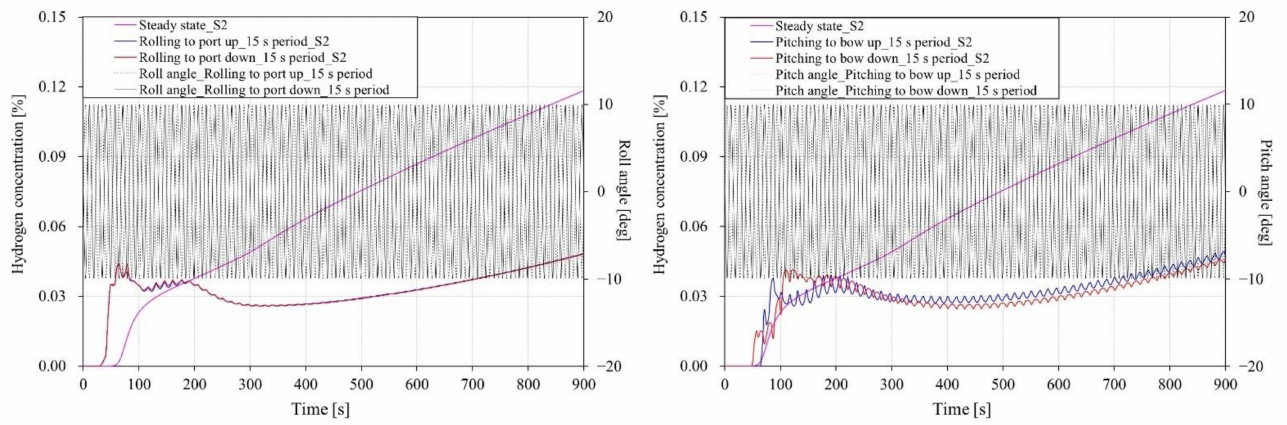
Figure 12. Central transversal cross-section of the hydrogen distribution: ( a ) Steady state; ( b ) Rolling to port up; ( c ) Rolling to port down.